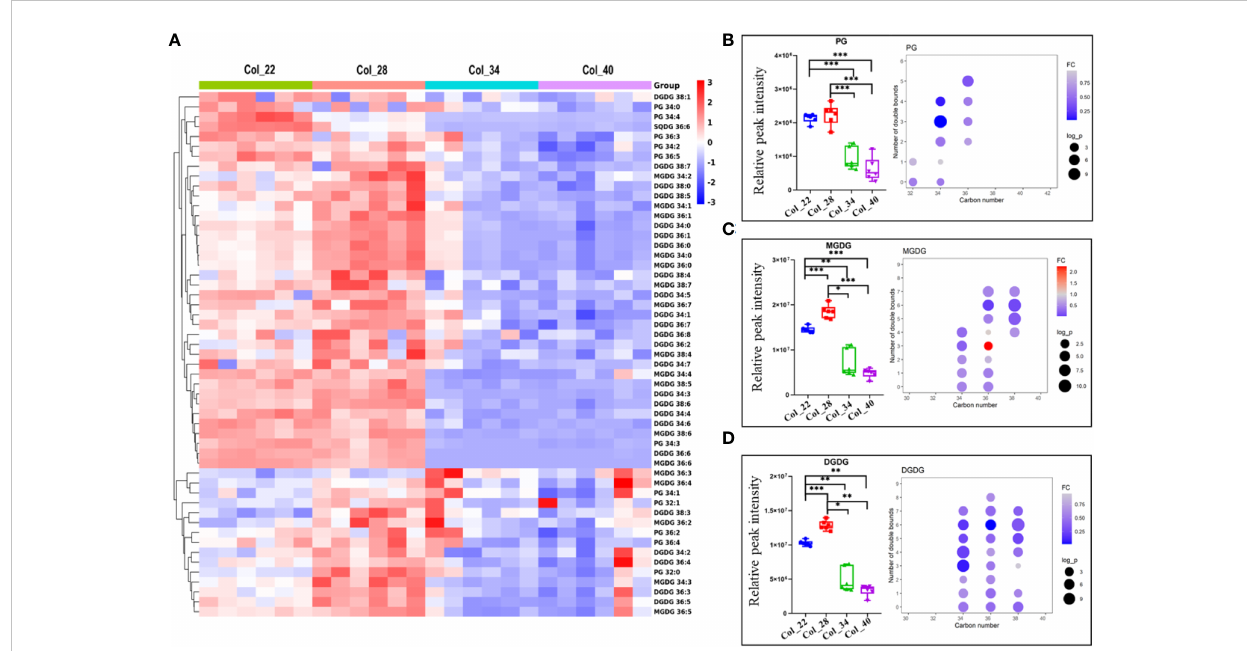
FIGURE 5 Comparative analysis of phosphatidylglycerol and galactolipids for Arabidopsis seed germination/seedling growth under four temperature conditions. (A) Heatmap showing Z score scaled the alteration of phosphatidylglycerol and galactolipids at moderate (22°C, 28°C) and the extreme high temperatures (34°C, 40°C). The relative enrichment of each metabolite in different samples were arranged in rows, and the relative levels of all metabolites in each sample were distributed in columns. The grids in heatmap represented metabolites, and shades of color represented relative level of metabolites. Red and blue colors indicate an increase and a decrease of metabolite level, respectively, and white color means no change. Col_22 means seeds germinated at 22 °C, Col_28 means seeds germinated at 28°C, Col_34 means seeds germinated at 34 °C, Col_40 means seeds germinated at 40 °C. (B – D) Lipid classes content differences of phospholipids under four different temperature (small fi gure on the left of block diagram) and changes in lipid content of different molecular species between low temperature group and high temperature group (small fi gure on the right of block diagram). The FC difference was calculated as high temperature group vs. low temperature group. Lipids shown here are PG (B) , MGDG (C) and DGDG (D) . Phosphatidylglycerol (PG), Monogalactosyldiacylglycerol (MGDG), Digalactosyldiacylglycerol (DGDG). Data are presented as mean ± SD. * P < 0.05, ** P < 0.01, *** P <